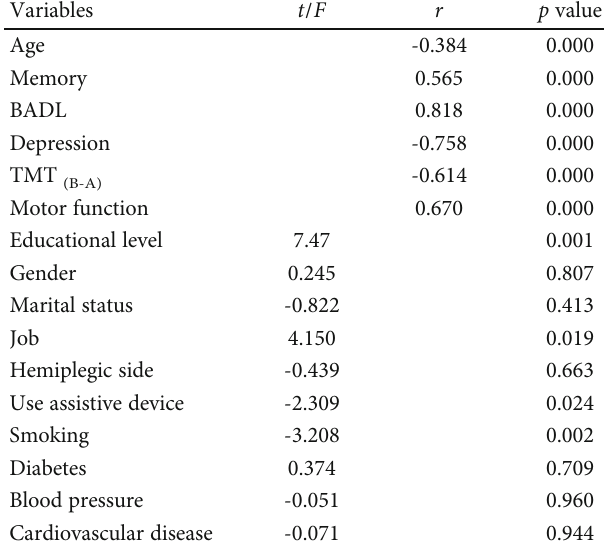
Table 3: Univariate analysis and correlation of di ff erent variables with instrumental activities of daily